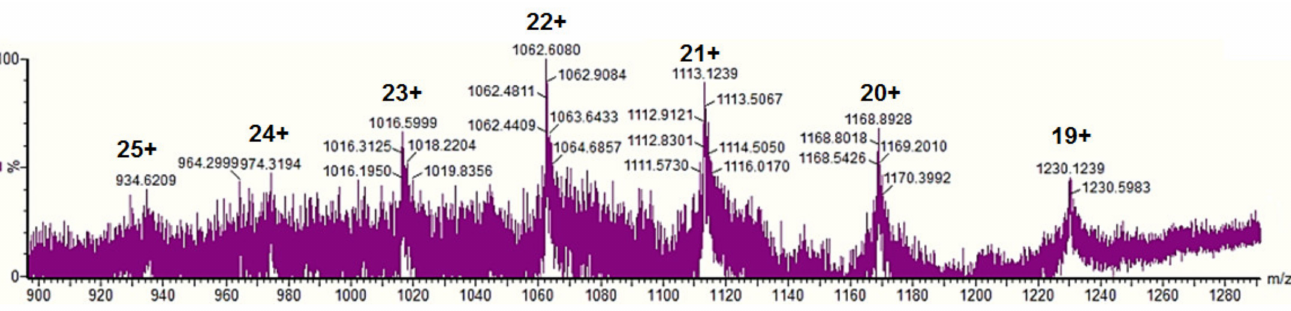
Figure 2. ESI mass spectrum of the extracted zein from the maize inbred KWS 3381 with 95 % ethanol in water from flour having 710 µ m particle